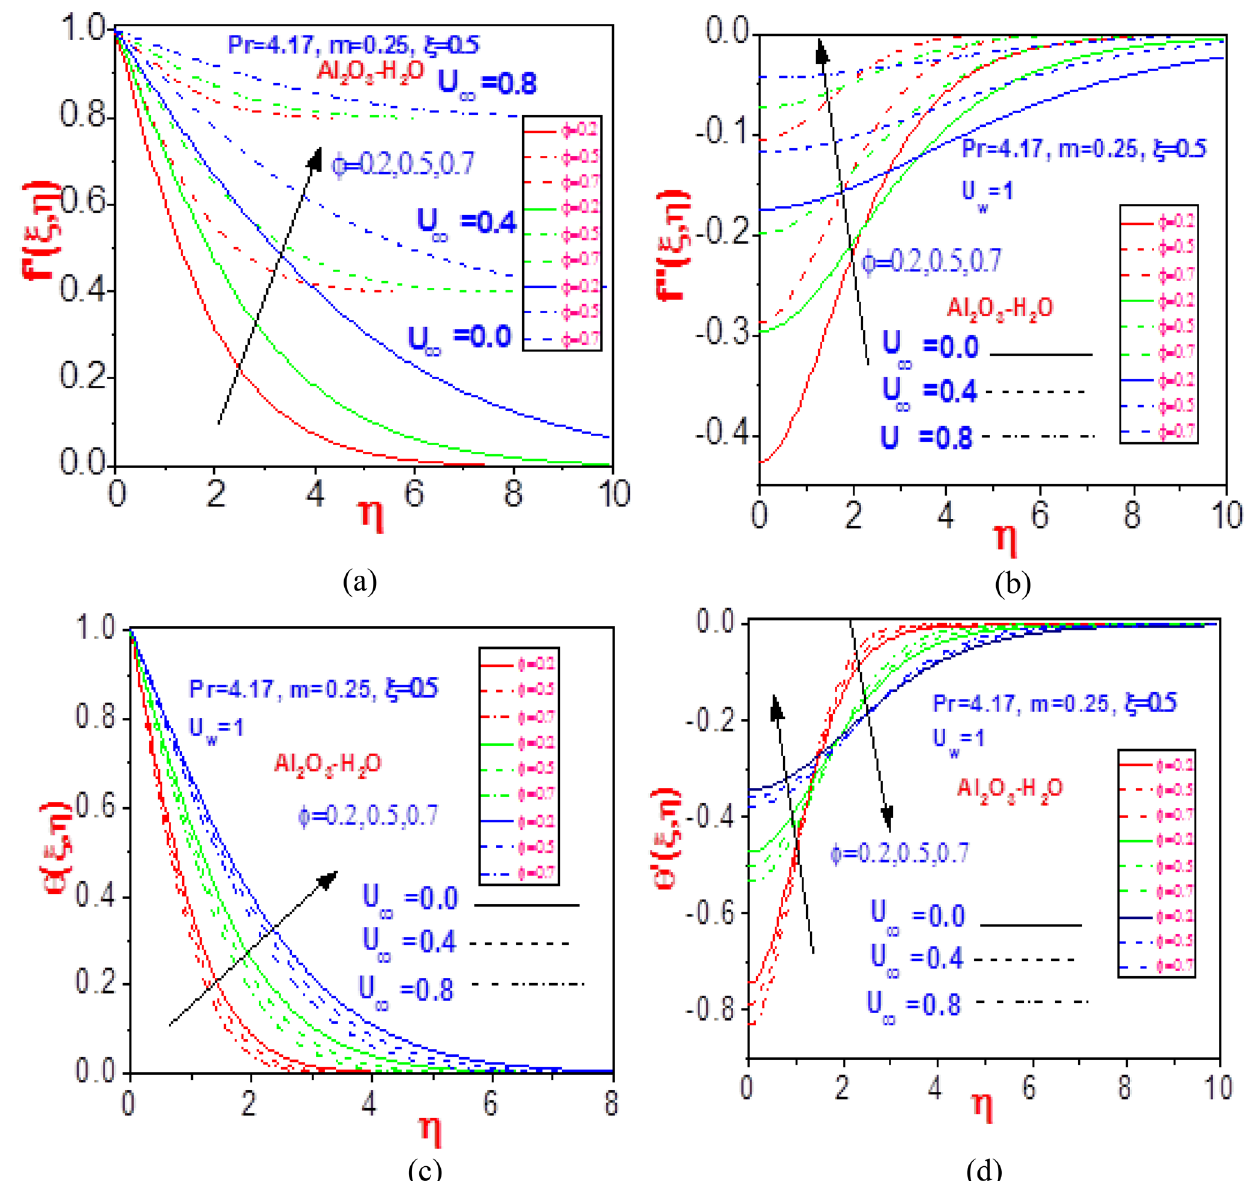
Figure 7. Profiles of ( a ) velocity f ′ (ξ , η) , ( b ) missing velocity slope f ′′ (ξ , η) , ( c ) temperature θ(ξ , η) , and ( d ) missing temperature slope θ ′ (ξ , η) with different values of U ∞ and φ for Al 2 O 3 -H 2